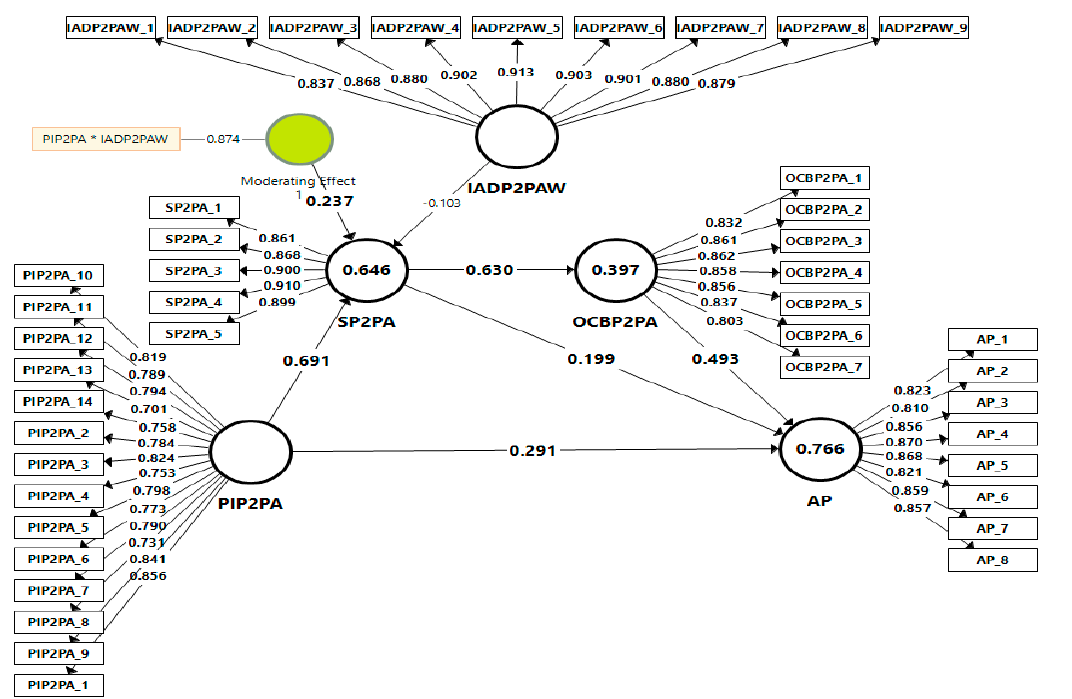
Figure 2. The tested structural and measurement model. PIP2PA → Positive Impacts of P2PA; AP → Agritourism performance; SP2PA → Support for P2PA; OCBP2PA → Organizational Citizenship Behavior toward P2PA; IADP2PAW → Information on Agritourism destination on the P2PA website; * moderating effect.